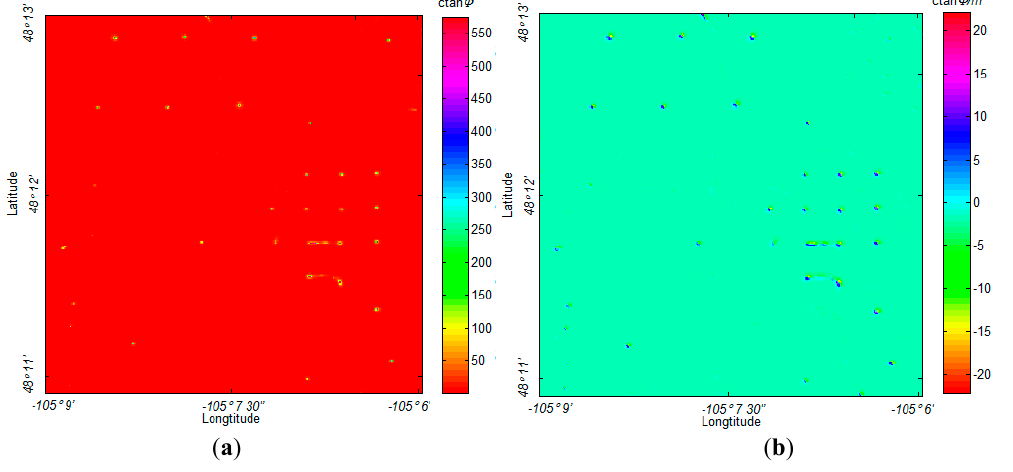
Figure 14. ( a ) MDTA map of the field data ( α = 20); ( b ) Horizontal gradient map of ( a